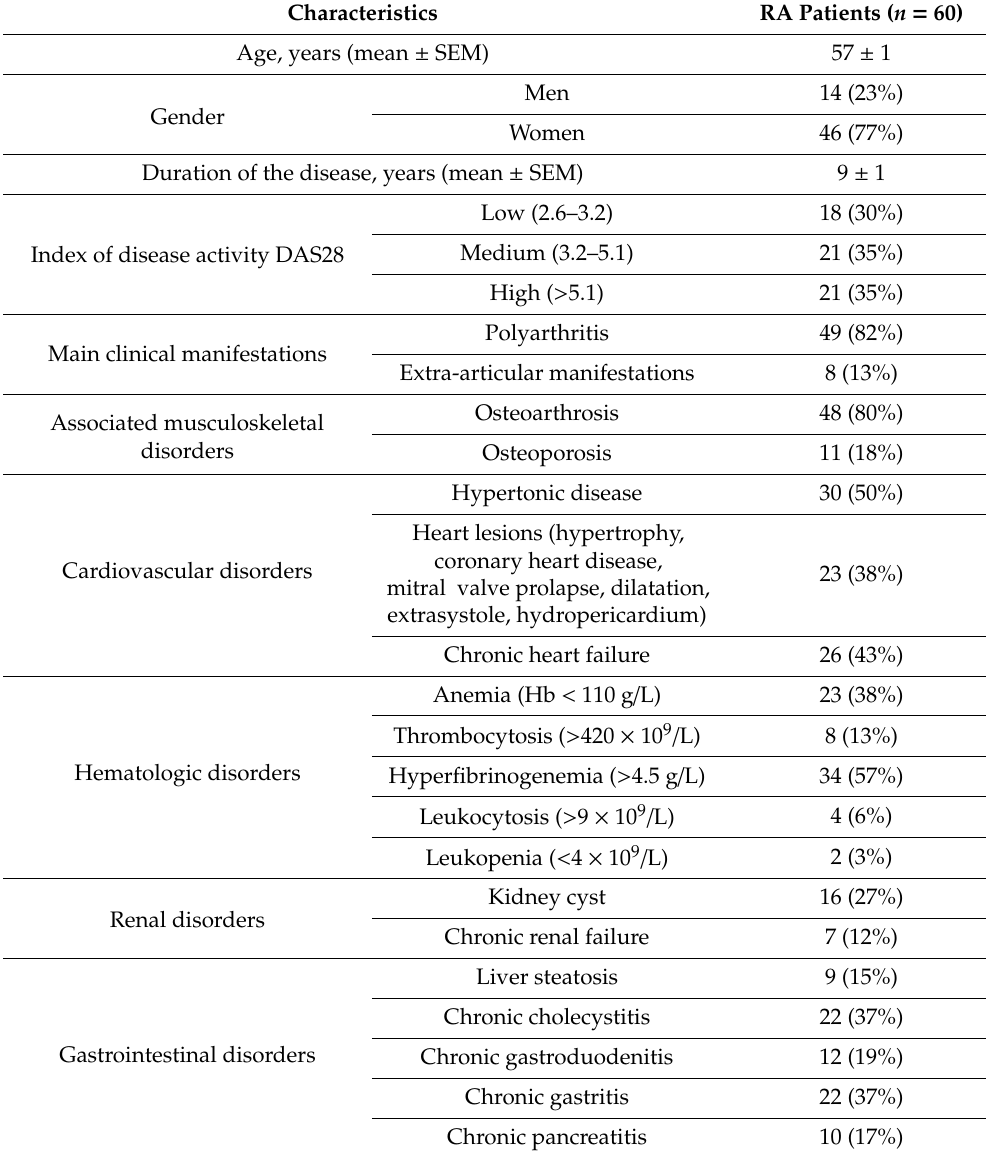
Table 2. Clinical characteristics of the RA patients enrolled in this